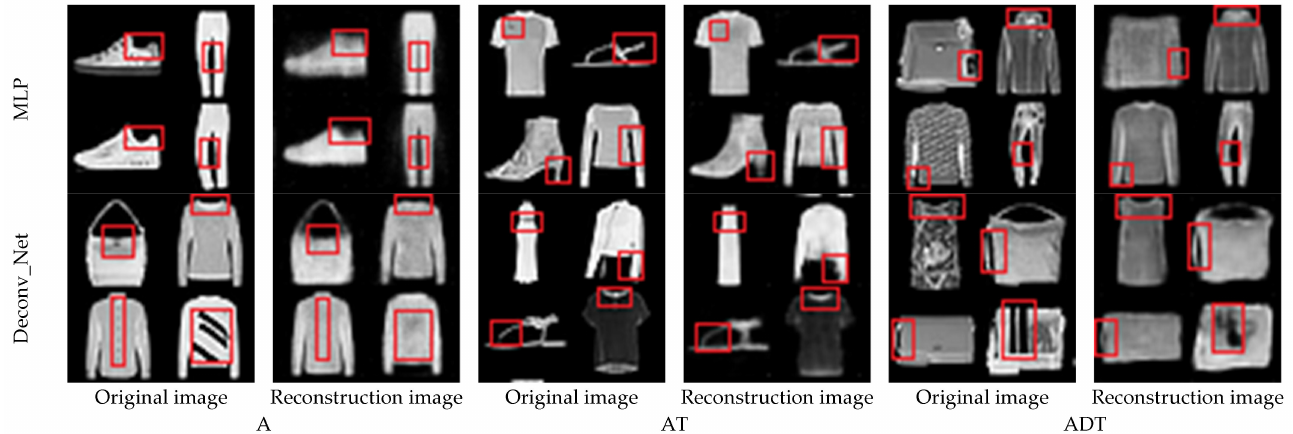
Figure 14. Reconstruction results of at a 98% compression